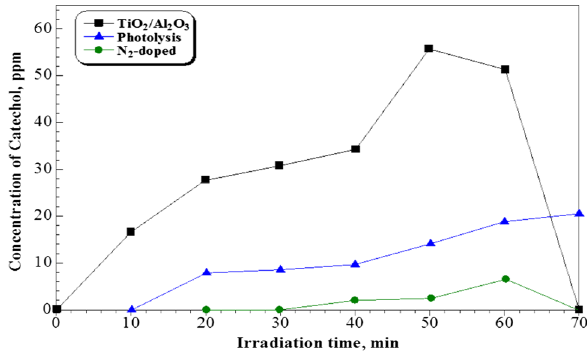
Fig. 8 Formation of catechol using TiO on glass substrates during the degradation of